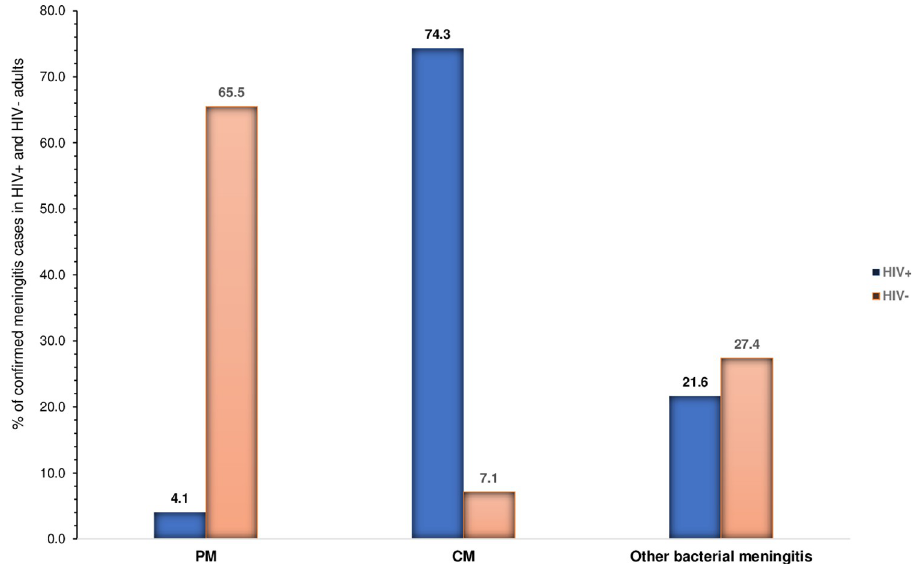
Fig 2. Proportion of Cryptococcal and pneumococcal meningitis in among HIV- infected and HIV- uninfected adults. Each bar represents the relative frequency of the main cause of meningitis among two groups of patients. PM : Pneumococcal meningitis; CM : Cryptococcal